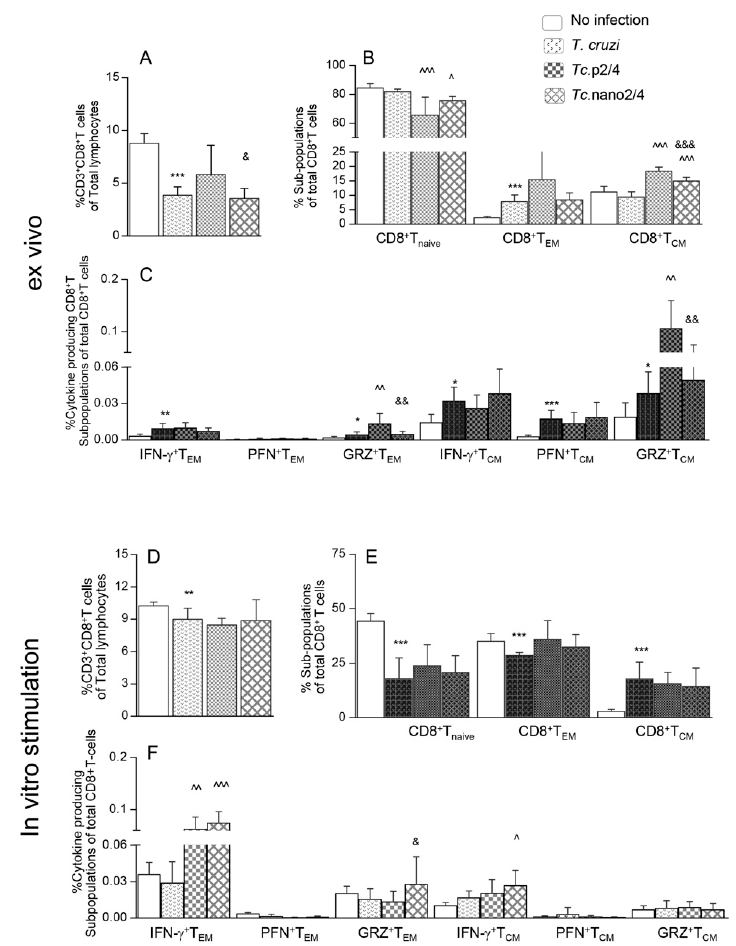
Figure 2. Effect of nano-immunotherapy on ex vivo profile and recall response of splenic CD8 + cells in Chagas mice. C57BL / 6 mice were challenged with T. cruzi , treated with two doses of nano2 / 4 or p2 / 4, and euthanized in chronic phase. Splenocytes were used for ex vivo profiling ( A – C ) or cultured for 48 h with TcL to evaluate the recall response ( D – F ), determined by flow cytometry. ( A , D ) Splenic percentages of CD8 + T cells. ( B , E ) Frequency of CD8 + T cells with naïve, T EM , and T CM phenotypes. ( C , F ) CD8 + T EM and T CM subpopulations were analyzed for the expression of IFN- γ , perforin (PFN), and granzyme B (GRZ). Data (mean ± SD) are representative of duplicate observations per sample ( n = 4–5 mice per group). Significance was calculated and annotated as described in legends of Figure 1.